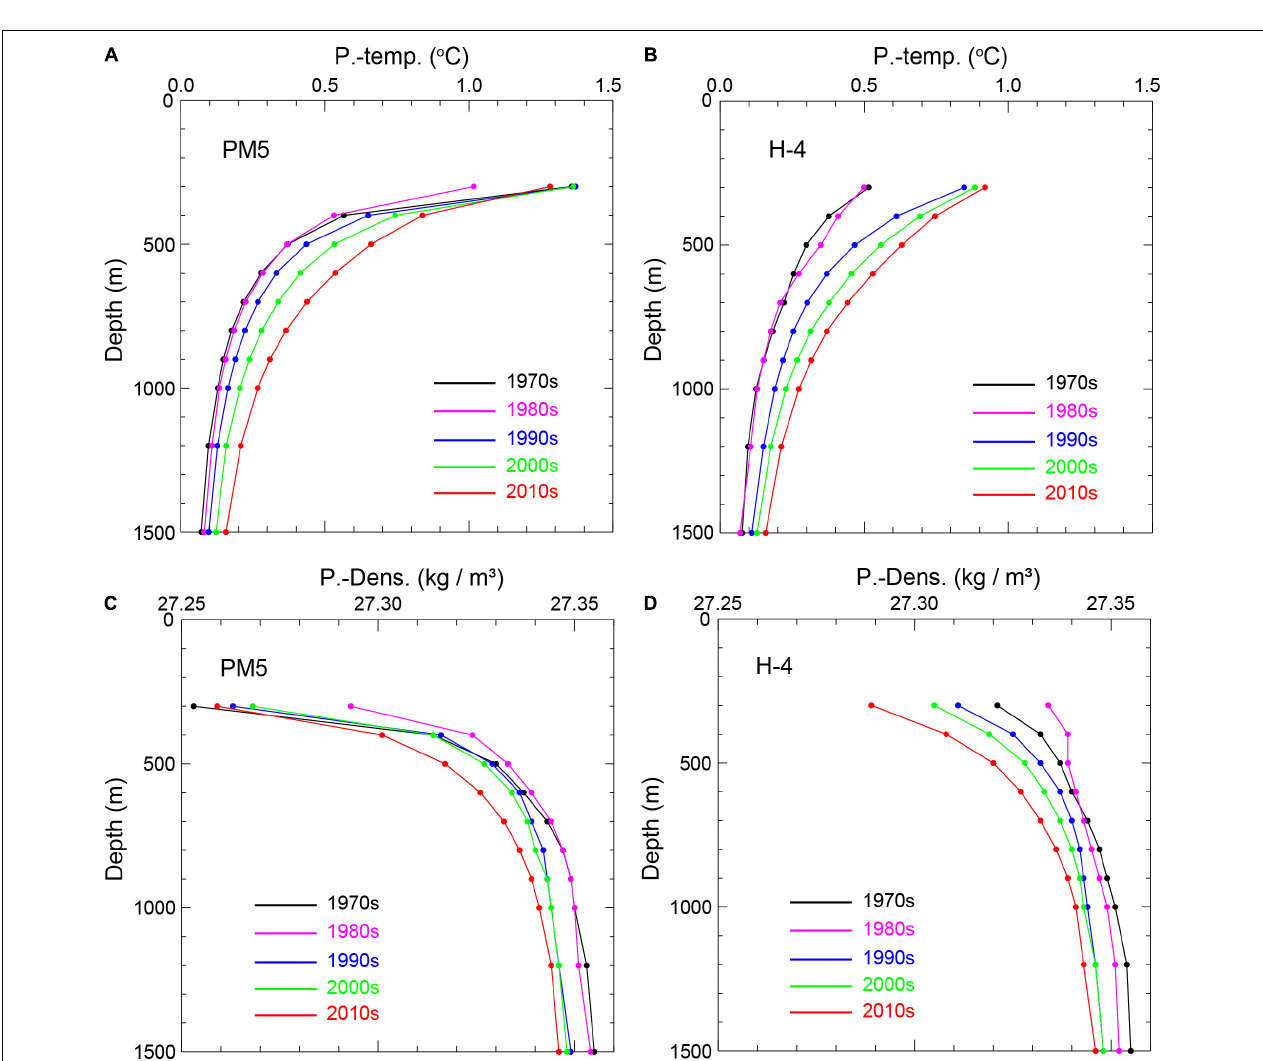
FIGURE 9 | Decadal mean profiles of PT (A,B) and PD (C,D) at Stas. PM5 (left panels) and H-4 (right panels) in a depth rage 300–1500 m.